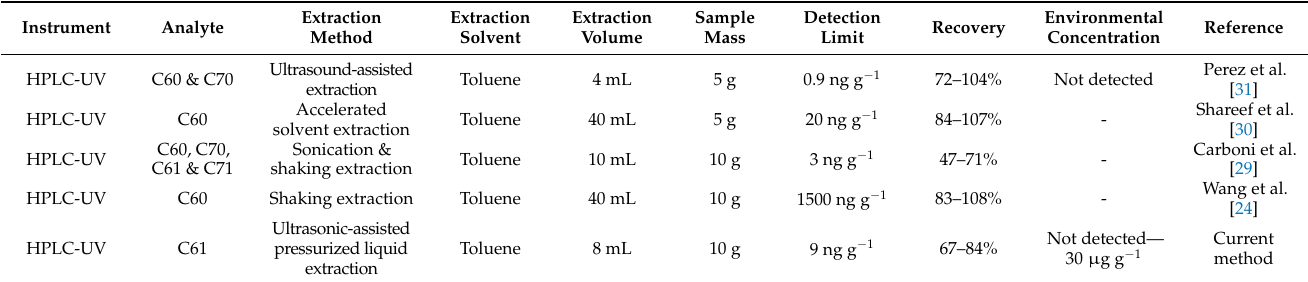
Table 3. Comparison of analytical methods from literature with current